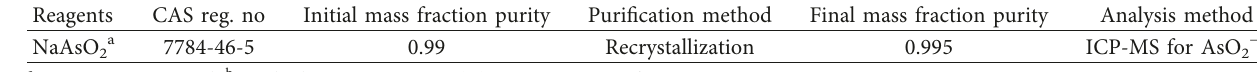
Table 1: Source and purity of the chemical used in this work.